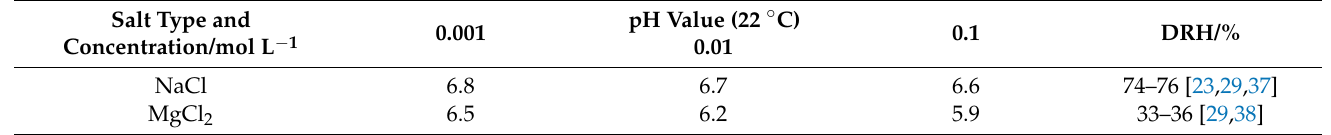
Table 2. Measured pH values of MgCl 2 and NaCl aqueous solutions applied onto the CP1000 surface and literature data on deliquescence relative humidity (DRH) of saturated salt solutions at 25 ◦